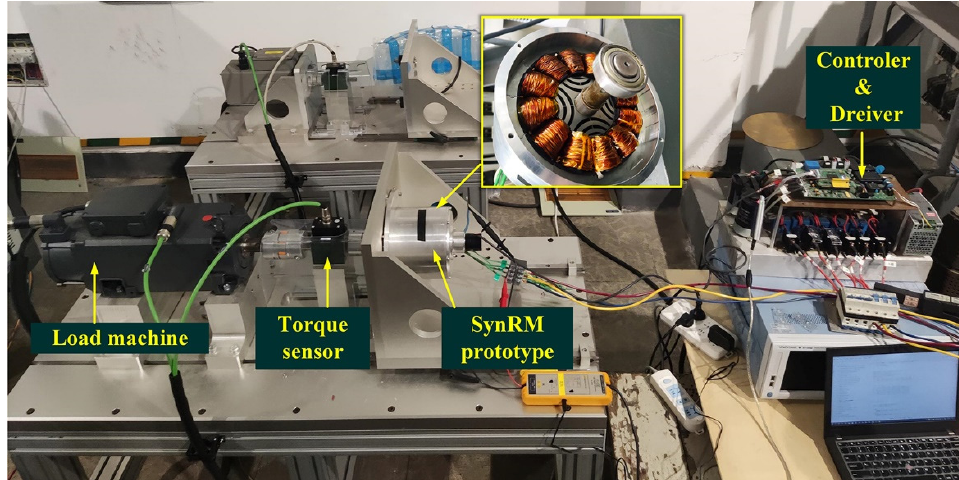
Figure 15. Experimental platform.